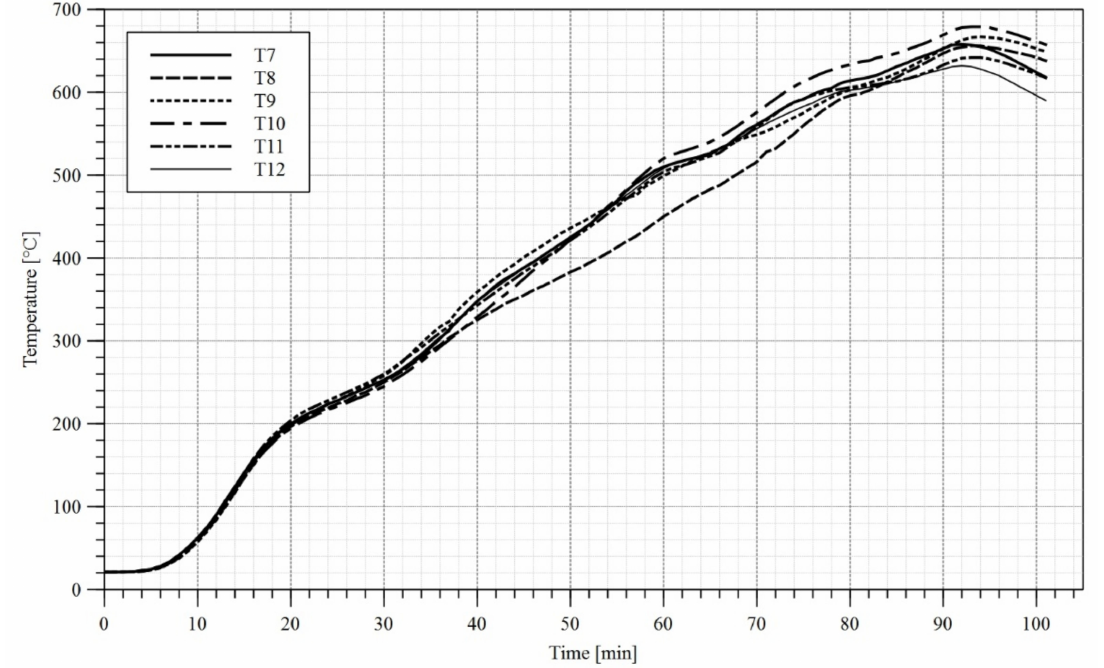
Figure 13. Temperature–time diagram, web, test